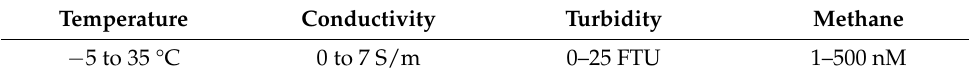
Table 1. Detection ranges of the